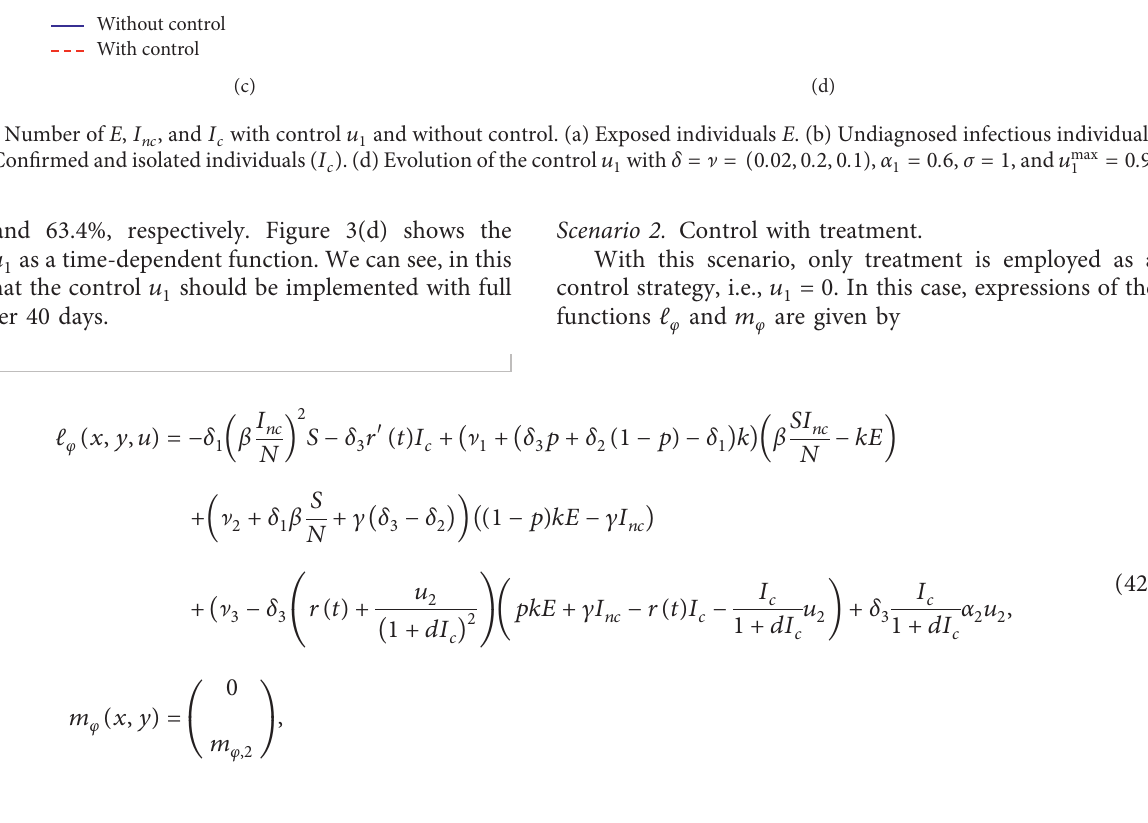
I u and without control. (a) Exposed individuals E . (b) Undiagnosed infectious individuals nc , and c with control 1